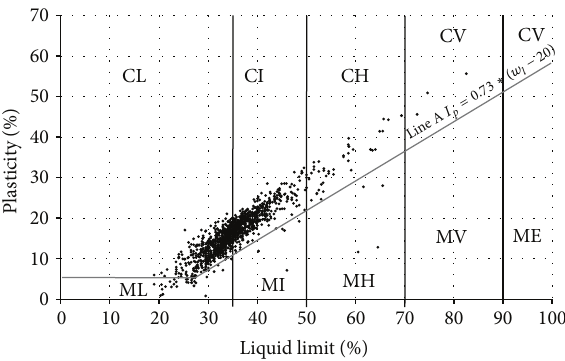
Figure 4: Diagram of plasticity of foundation soil samples.